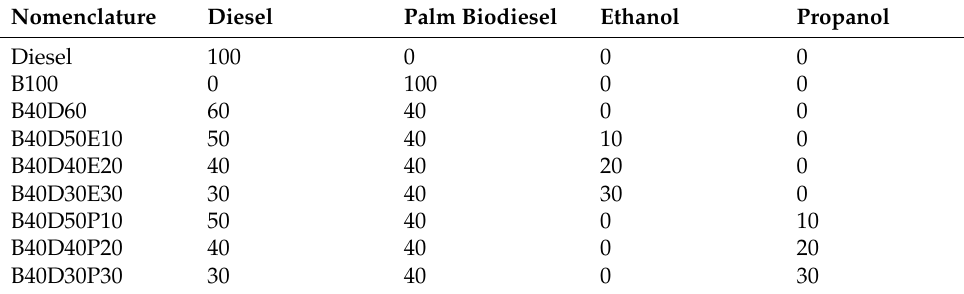
Table 3. Volumetric (%) concentration of tested fuels.